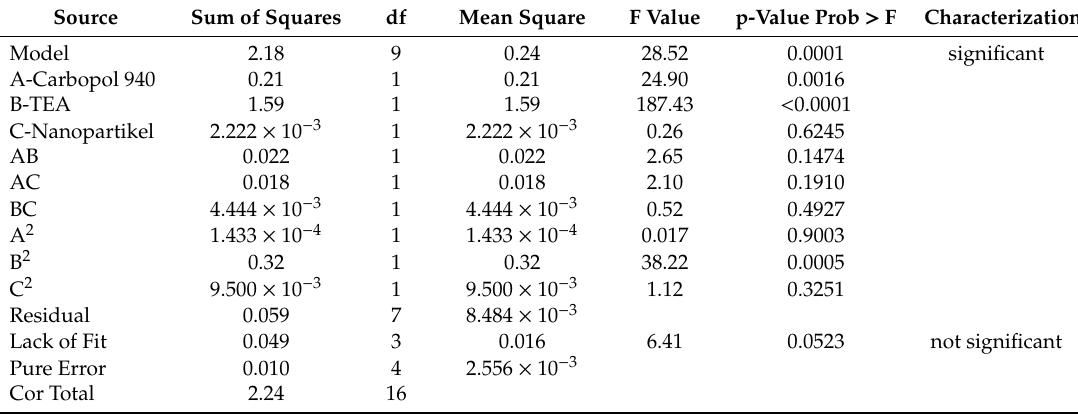
Table 4. ANOVA analysis for the quadratic model of the acidity degree of arabica co ff ee ground nanoparticles gel preparations.